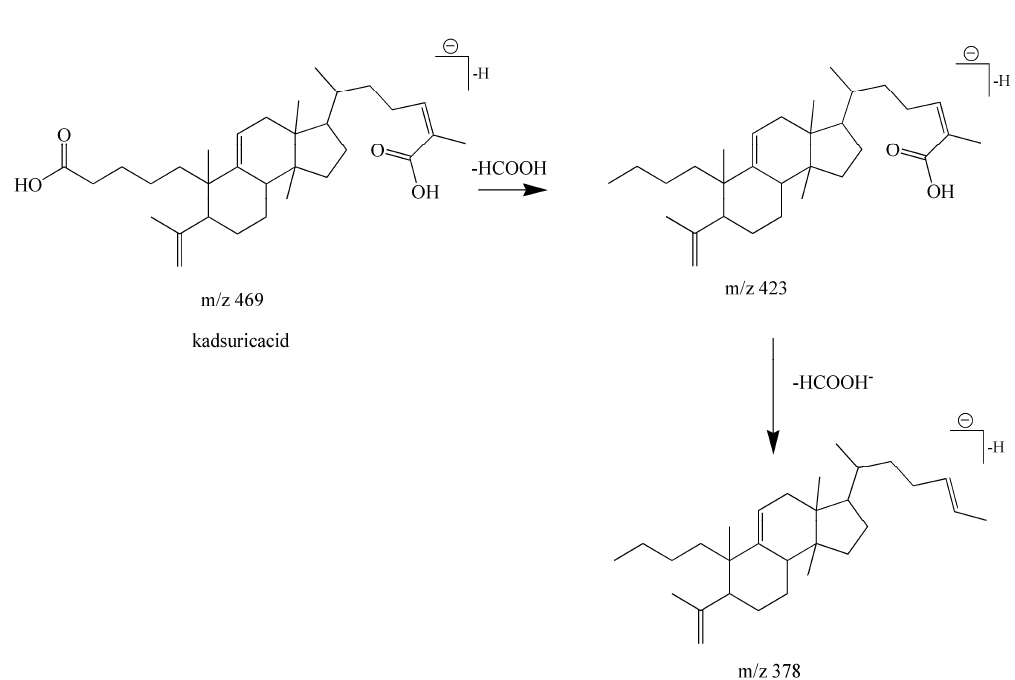
Figure 5. The specific fragmentation process of kadsuricacid in negative ion mode.